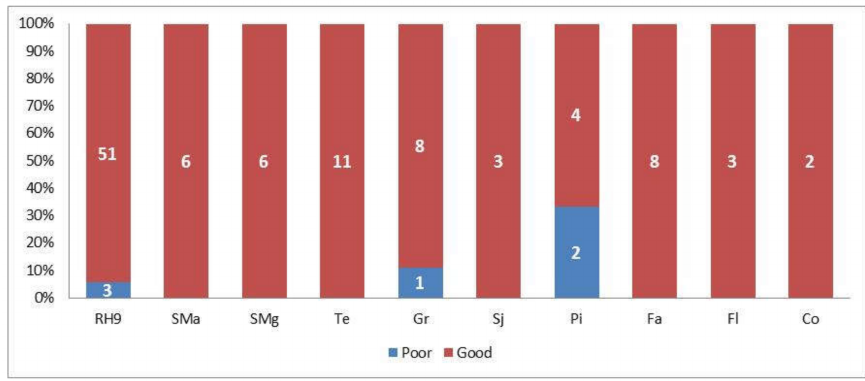
Figure 3. Groundwater bodies status in the Azores RBD in year 2015 (data from [28]; Poor and Good: groundwater bodies, respectively, in poor and good status according to the WFD